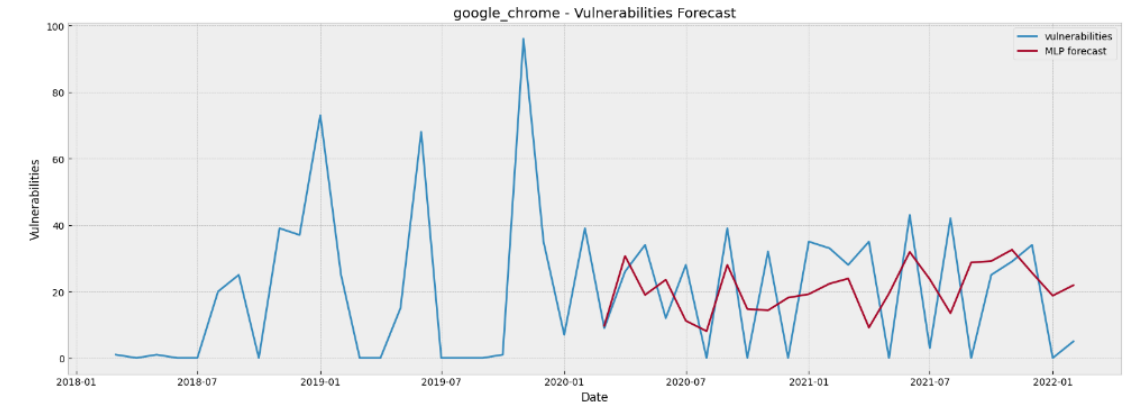
Figure 4. Google Chrome vulnerability forecasting for 24 steps ahead using MLP.